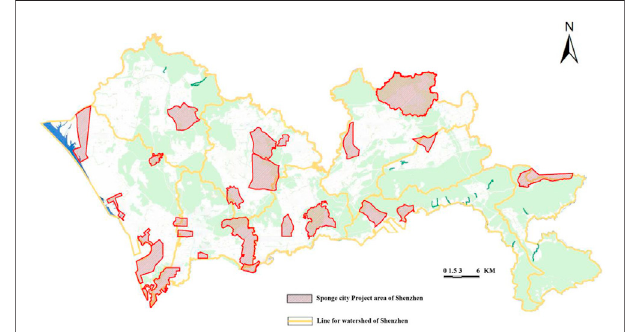
FIGURE 2 | Sponge city project areas within Shenzhen